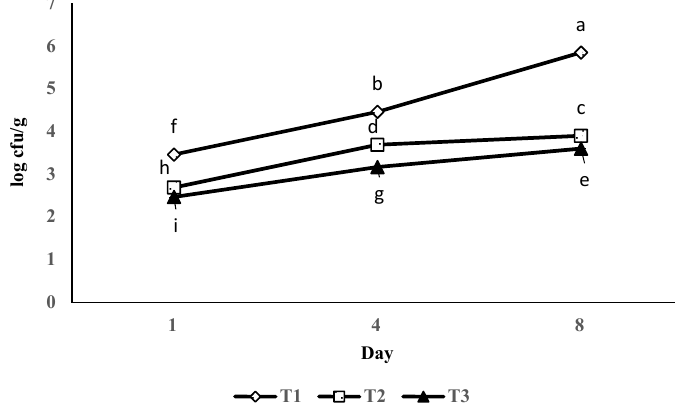
Figure 4. The effect of surimi ‐ based coating on aerobic plate count of shrimp during storage at 4 ± 1 °C. Data are given as mean values ± standard deviation ( n = 3). Different letters on the top of data bars indicate significant differences (Tukey’s test, p < 0.05) between mean values. T1, control; T2 surimi ‐ based coating without MMT; T3, surimi ‐ based coating with MMT.